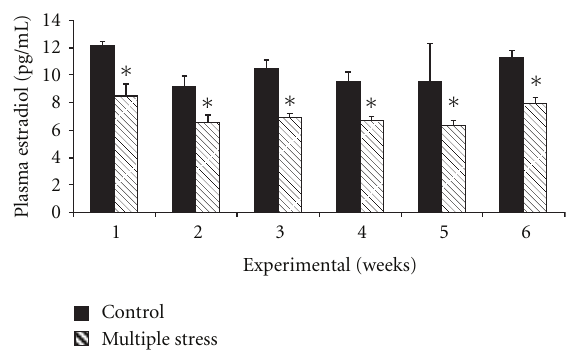
Figure 1: E ff ect of multiple stresses (thermal, nutritional, and walking stress) on the plasma estradiol levels in Malpura ewes. ∗ Indicates statistical significance to the respective control values at P < 0 .